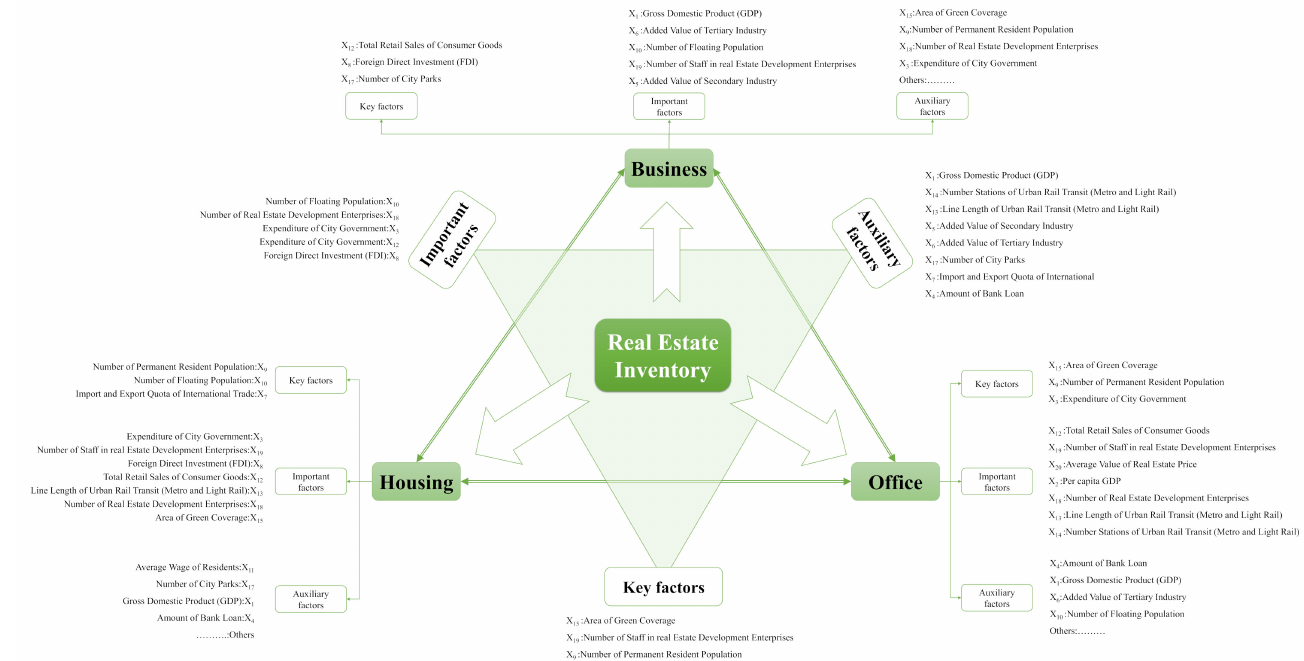
Figure 11. Driving mechanisms of spatial inequalities in the housing